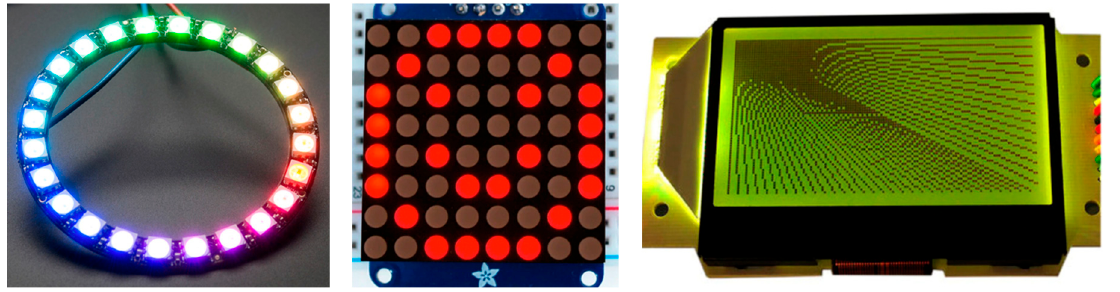
Figure 4. Visual actuators included in the